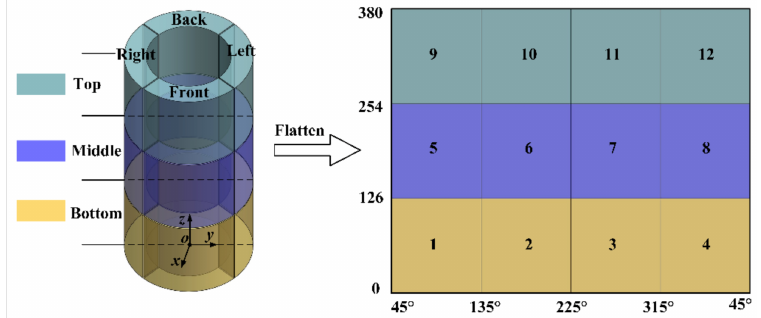
Figure 15. Calculation domain division of filter